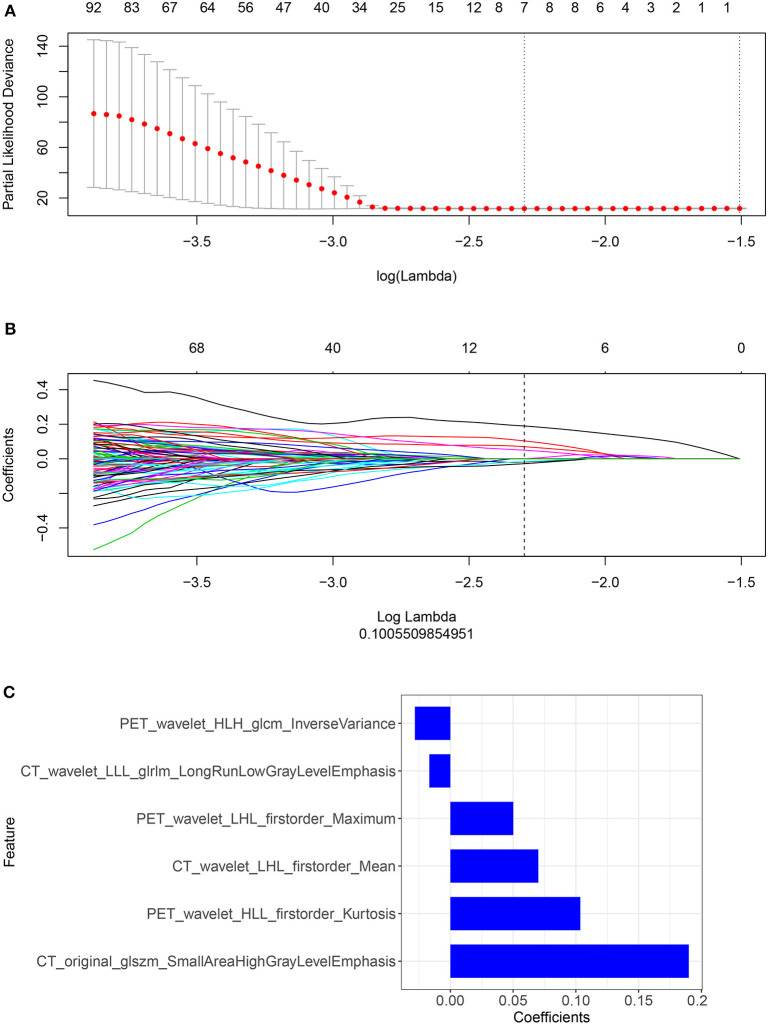
(A,B) Radiomic features were selected using the ten-fold cross-validation least absolute shrinkage and selection operator Cox regression model in the training cohort (number of patients: 221). The following two steps were included: determining the hyperparameter/lambda with a partial likelihood deviance as the criterion (top row) and using the optimized/lambda (the vertical dashed line) to select features with nonzero coefficients (bottom row). (C) A total of six important radiomic features were selected.